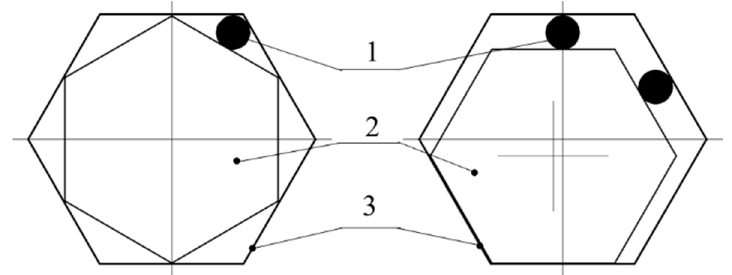
Figure 14. Matching relation between steel bars and bolt. 1—The steel bar, 2—The bolt, 3—The guiding mechanism’s small end.